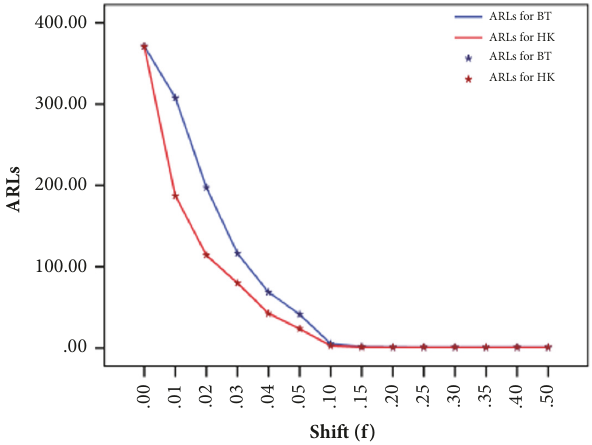
Figure 14: ARLs for proposed repetitive EWMA-RSS control charts using ratio estimators, for 𝜌 = 0.50 when 𝑟 𝑜 = 500 at 𝜆 = 0.1.